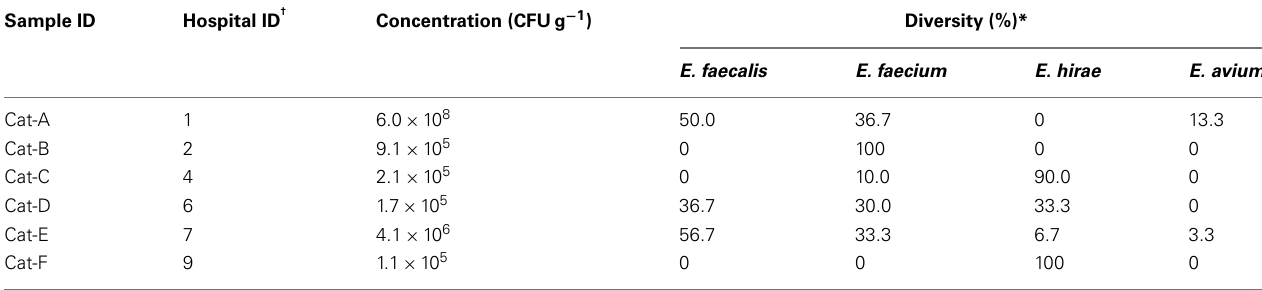
Table 1 | Enterococcal concentration and species diversity in the feces of resident cats from small animal veterinary